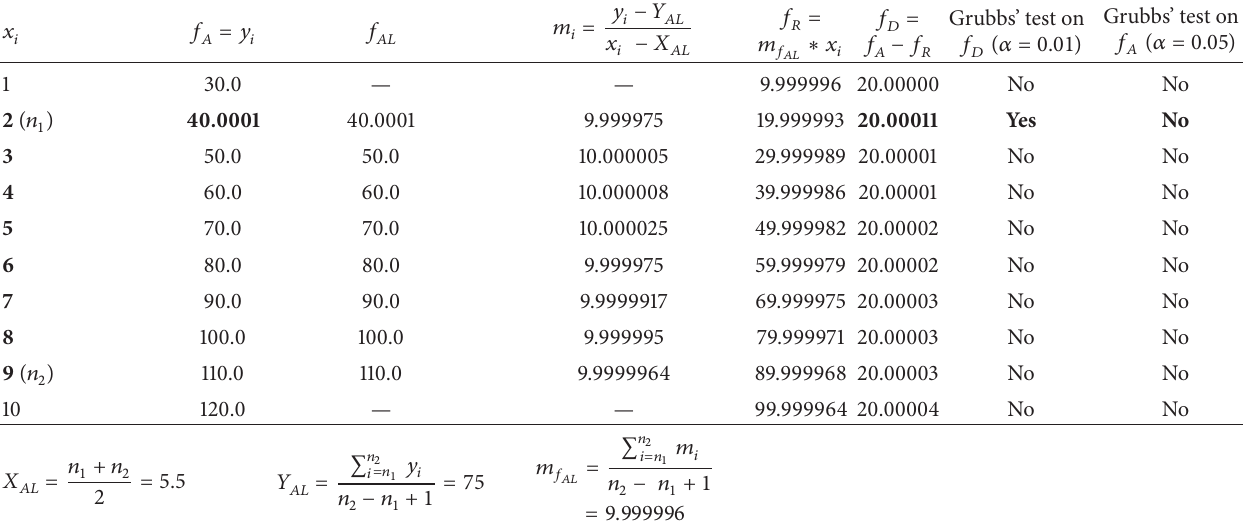
Table 5: Data set 3 ( 𝑛 = 10 ): neither the maximum nor the minimum is the outlier; deviation is very small. With new transformation technique, Grubbs’ test on 𝑓 𝐷 is capable of identifying the outlier with significance level of 0.01. However, Grubbs’ test on 𝑓 𝐴 is capable of identifying the outlier with even significance level of 0.05.